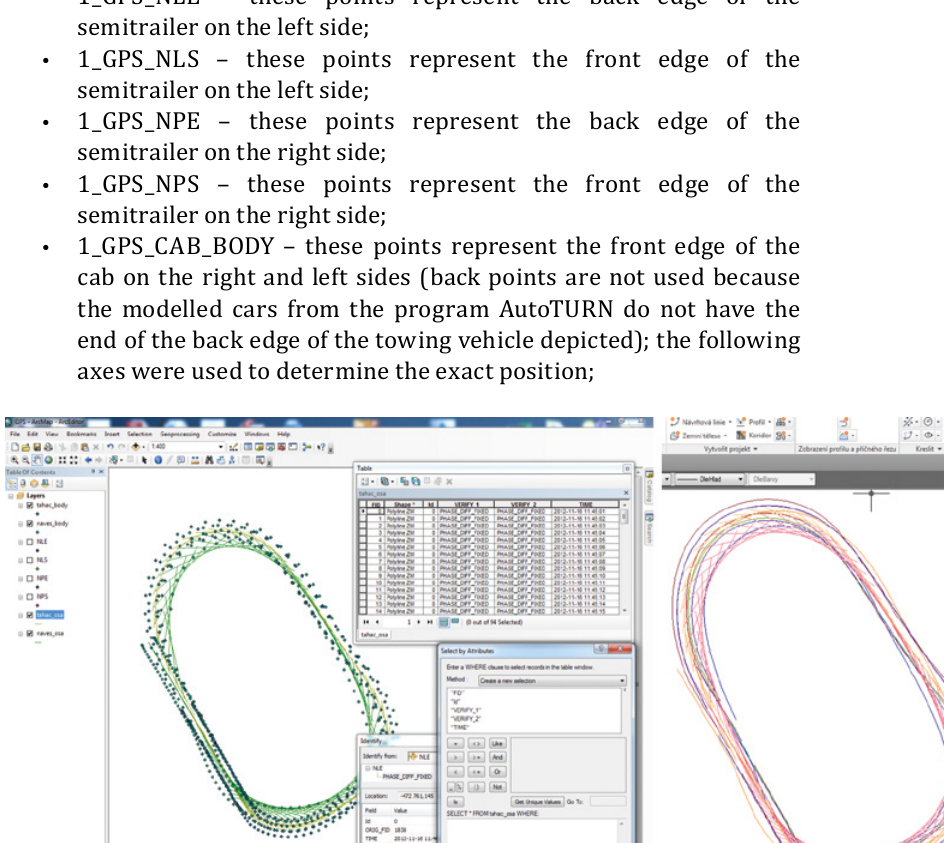
b) resulting curves of the edges of the semitrailer and the towing